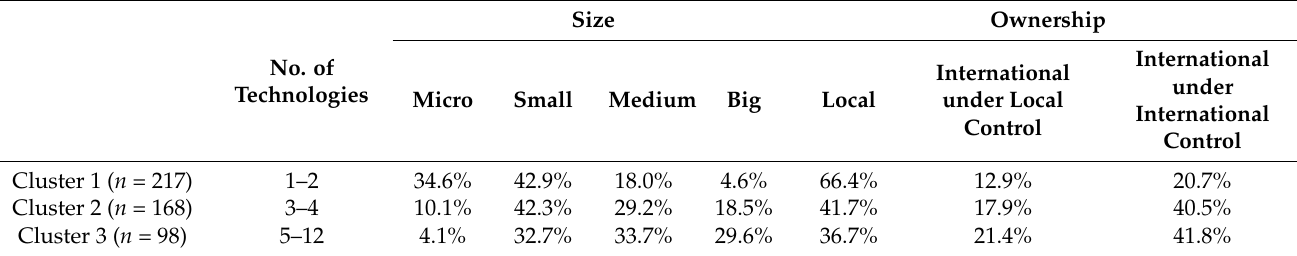
Table 4. Clusters of companies characterized by BMI based on number of new technologies.